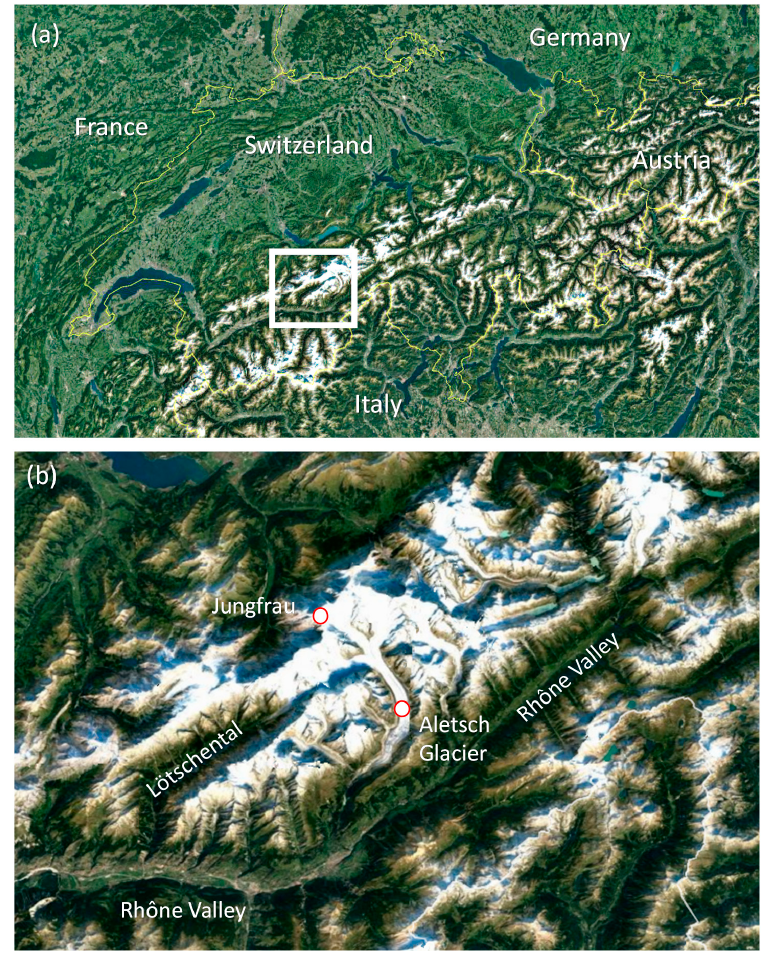
Figure 1. Topographic map of the area under investigation. ( a ): Switzerland (white rectangle: Lötschental area, modified after [42]). ( b ): Lötschental area, modified after [43].